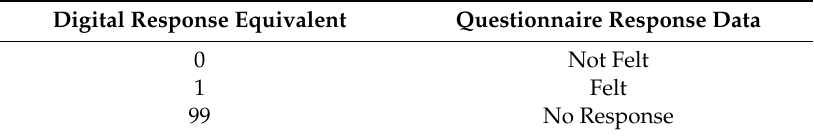
Table 11. The Process of data transfer to binary input.